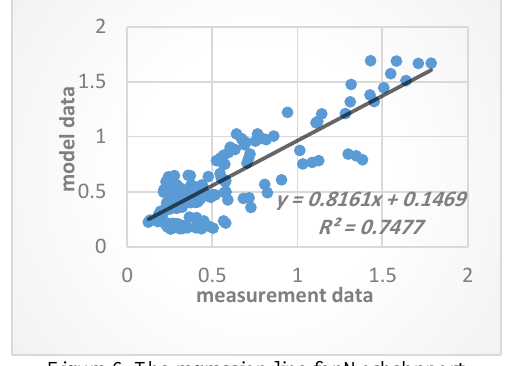
Figure 6. The regression line for Noshahr port.